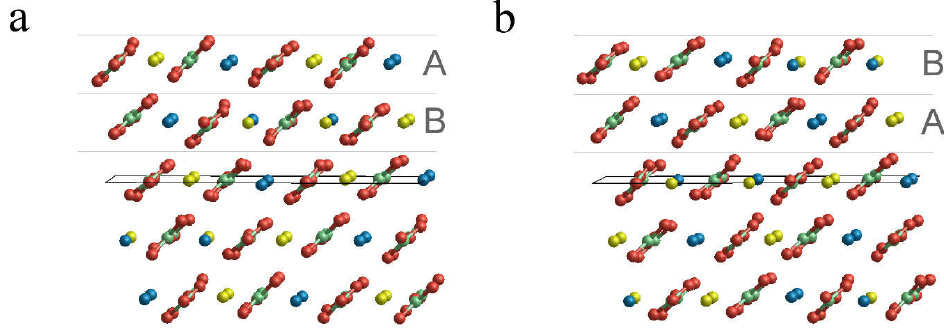
( a ) and ( b ) are the two possible terminations for the surface. The slabs are composed by a sequence of two different layers (… ABABA …). Ca: blue, Mg: yellow, C: green and O: red. two different layers (… ABABA …). Ca: blue, Mg: yellow, C: green and O: red.